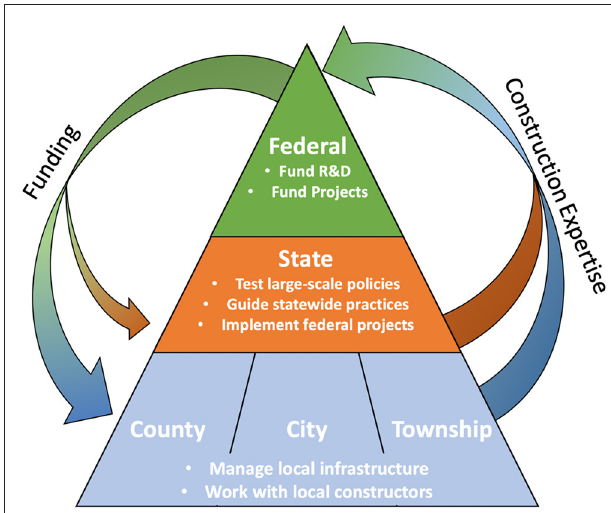
FIGURE 2 | Hierarchy of government interaction surrounding construction. Highlighting the bi-directionality of federal, state, and local policy related to